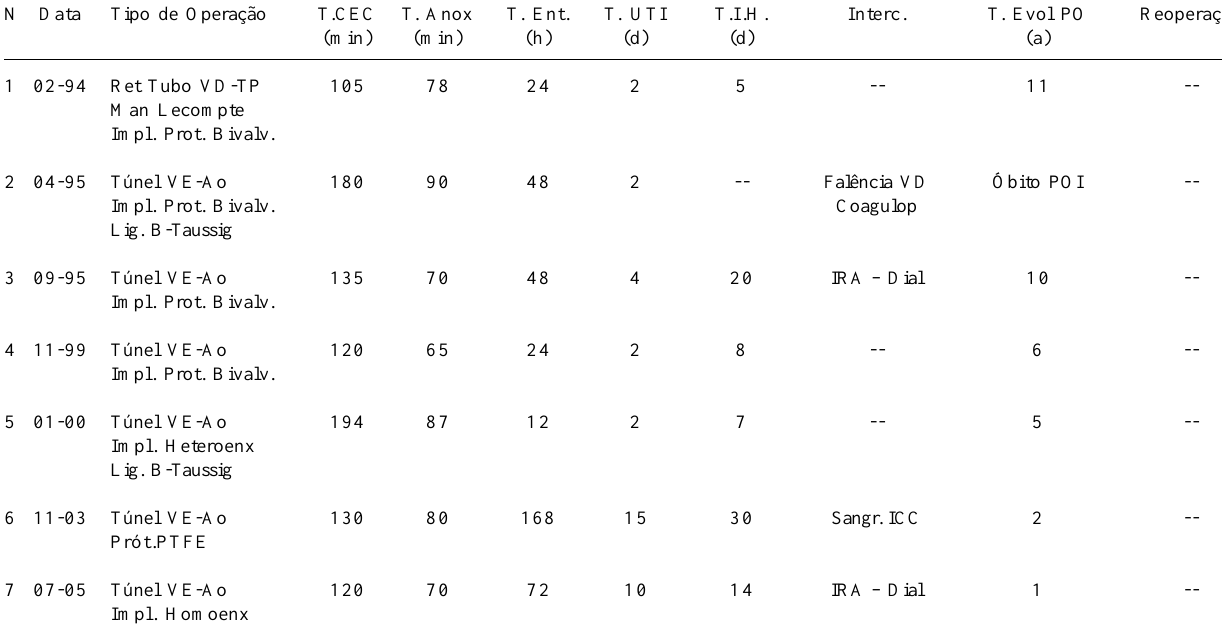
Tabela 2. Evolução pós-operatória imediata.